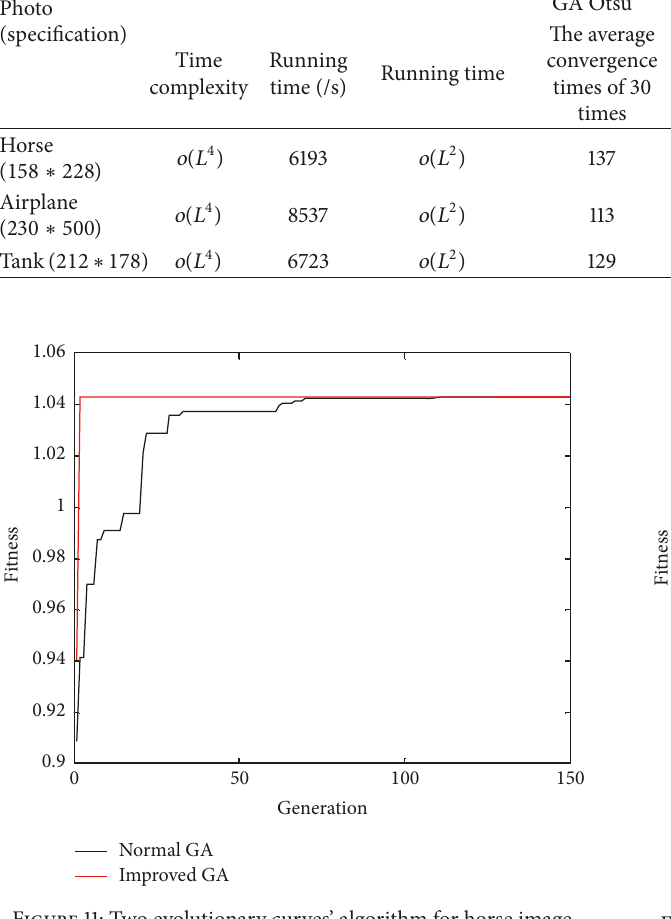
Figure 11: Two evolutionary curves’ algorithm for horse image.